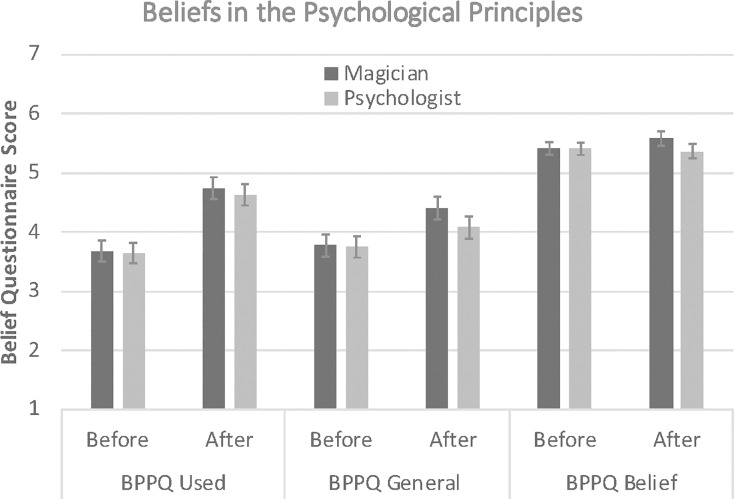
Mean PBBQ scores as a function of framing (magician vs. psychologist), type of PBBQ score before and after the performance.Error bars denote 95% Confidence Intervals.